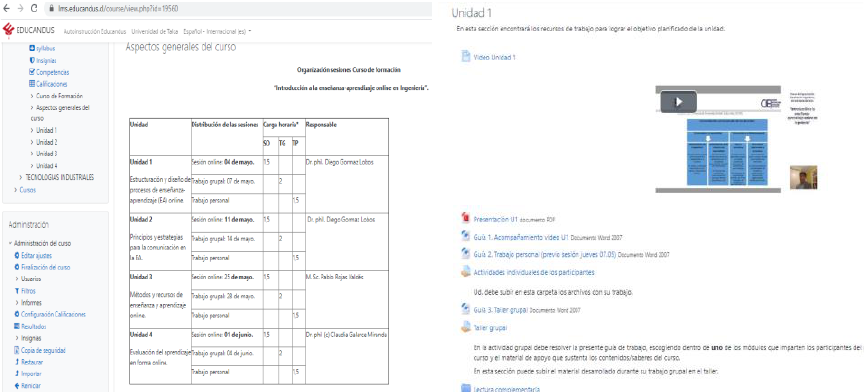
Fig. 1. Overview of the main page of the pilot course in EP at EDUCANDUS. https://lms.edu-